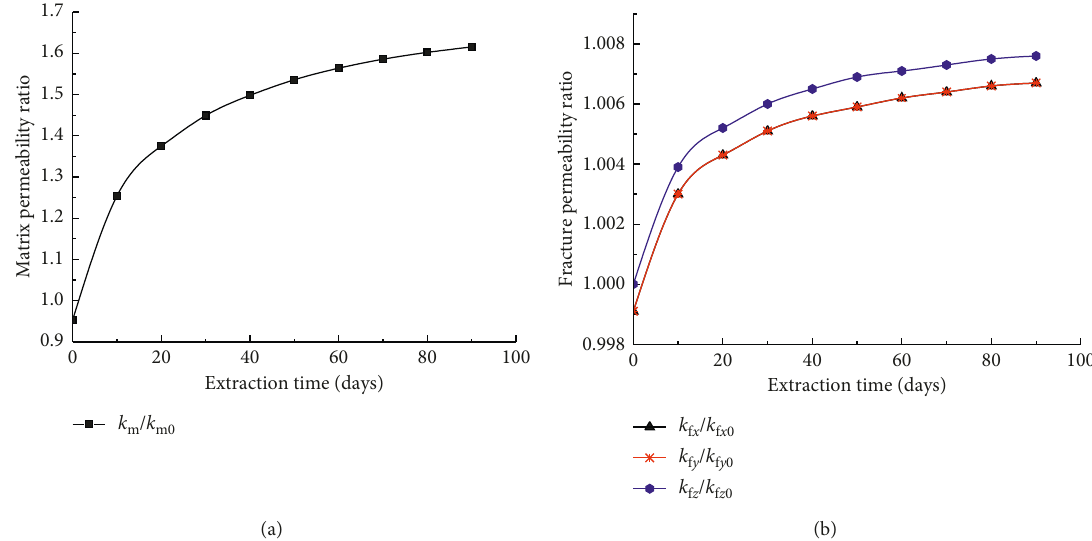
Figure 8: Permeability evolution with the anisotropic coefficient λ � 0. (a) Matrix permeability. (b) Fracture